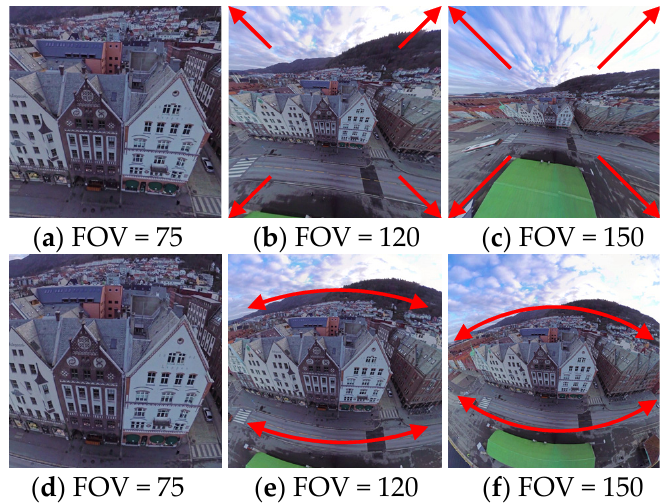
Figure 6. Distortions resulting from the perspective projection [33] ( a – c ) and stereographic projec- tion [33] ( d – f ).